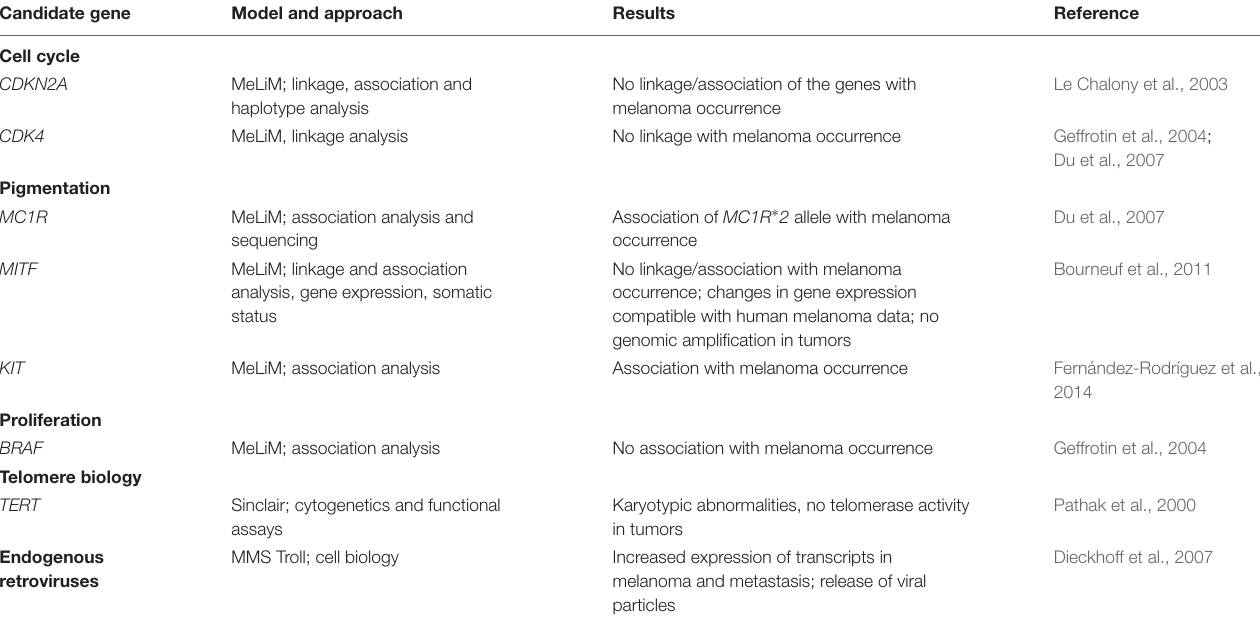
TABLE 3 | Summary of findings on candidate gene studies in swine melanoma